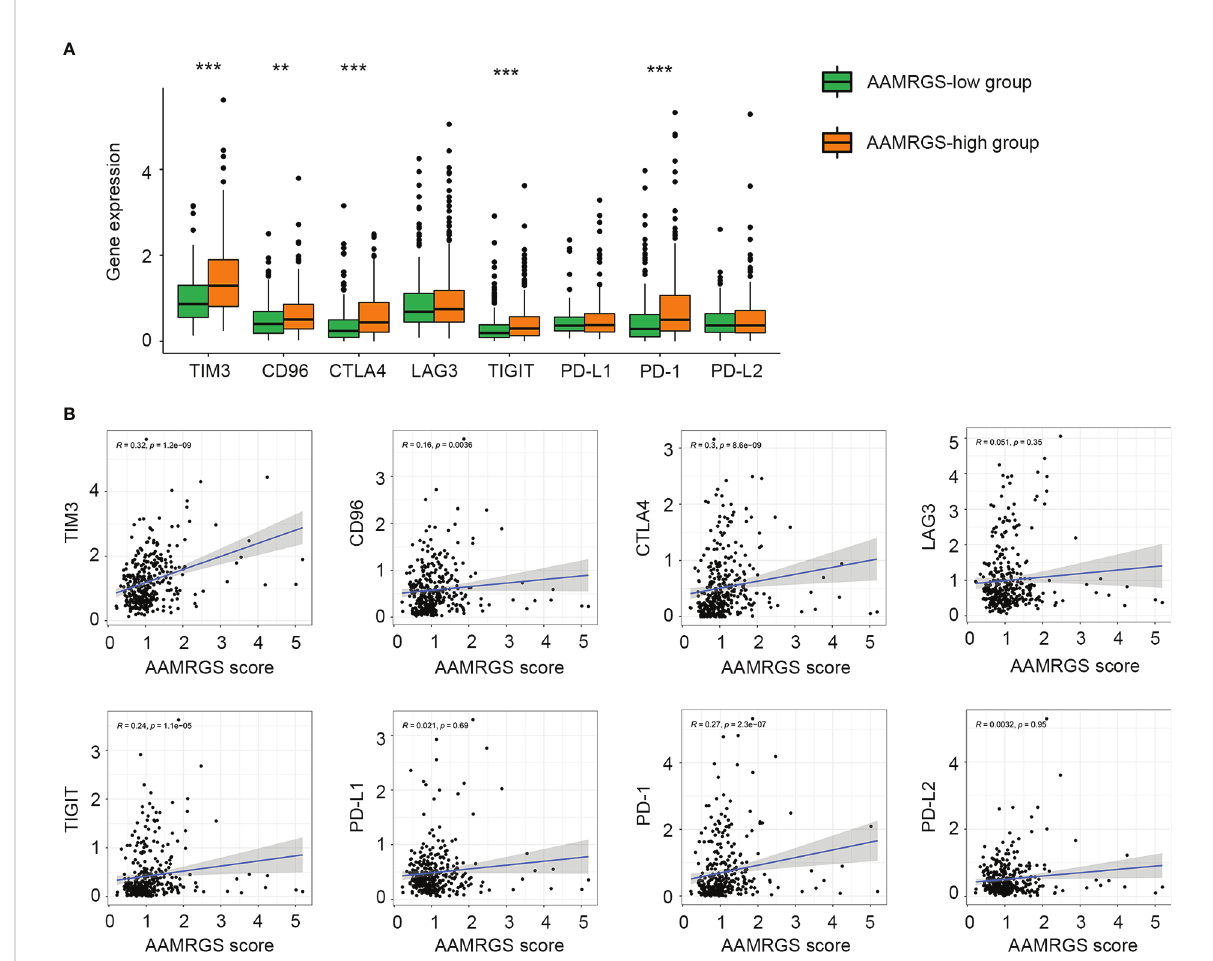
FIGURE 7 Association of the AAMRGS scores with immune checkpoints. (A) Differential expression of immune checkpoints between the AAMRGS-high and AAMRGS-low groups. (B) Correlation analysis of immune checkpoints and the AAMRGS scores. **P < 0.01, ***P <